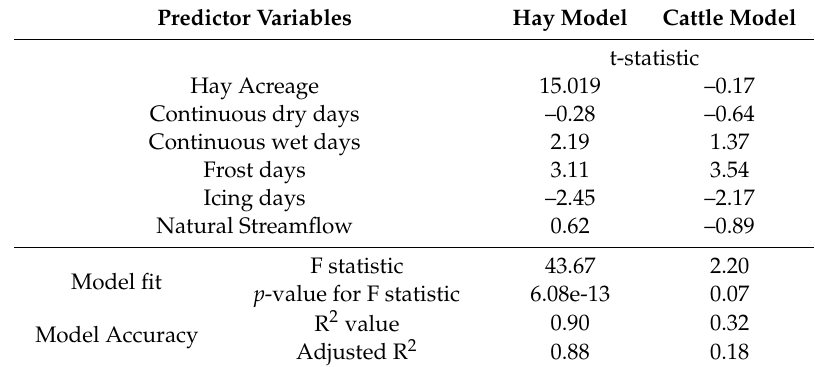
Table 2. Summary statistics for the results of multilinear regression.